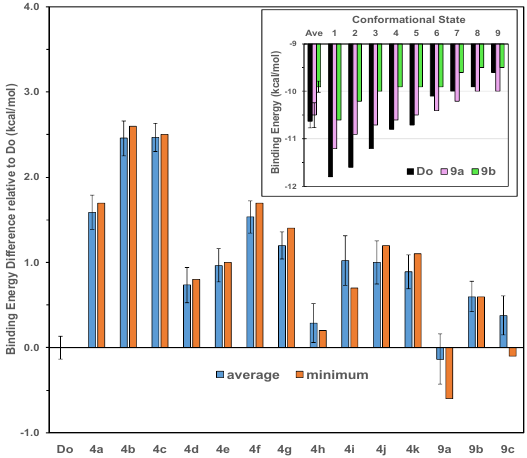
Figure 3. Summary of binding energies obtained for all compounds reported herein including comparative conformations of Do versus compounds 9a and 9b . Sci. Pharm. 2017 , 86 , 2